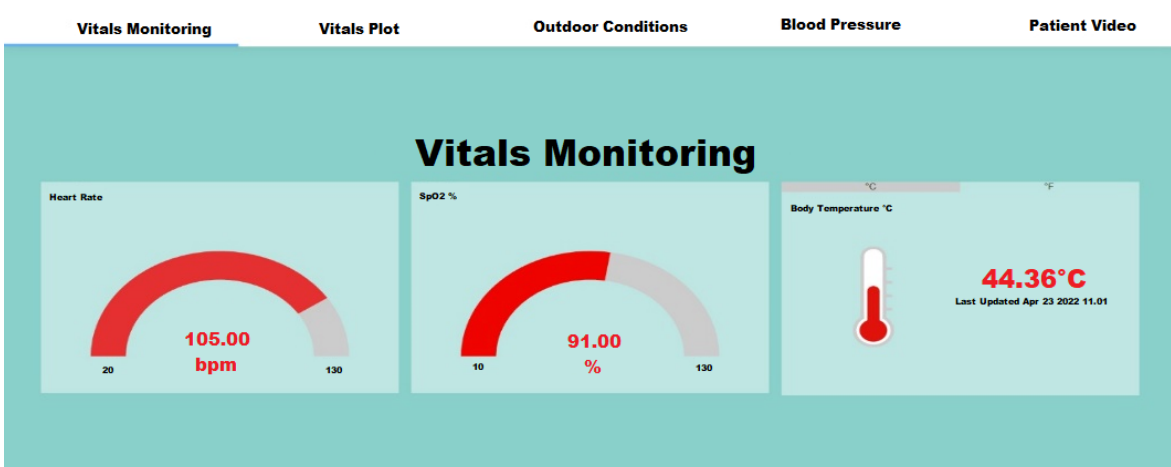
Figure 12. Website reaction during a spike in vitals and